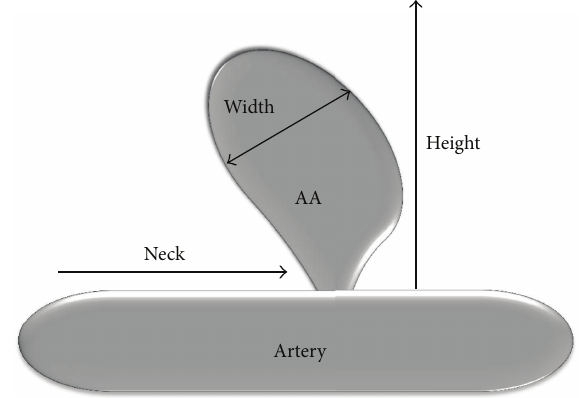
Figure 4: Drawing showing the measurement technique of the saccular aneurysm (AA).